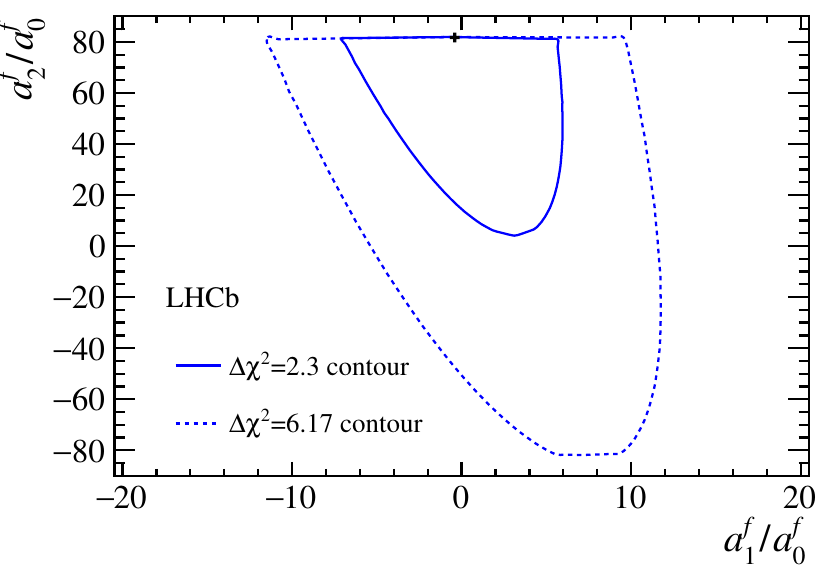
/a f versus a f /a f . The black cross marks 1 0 2 0